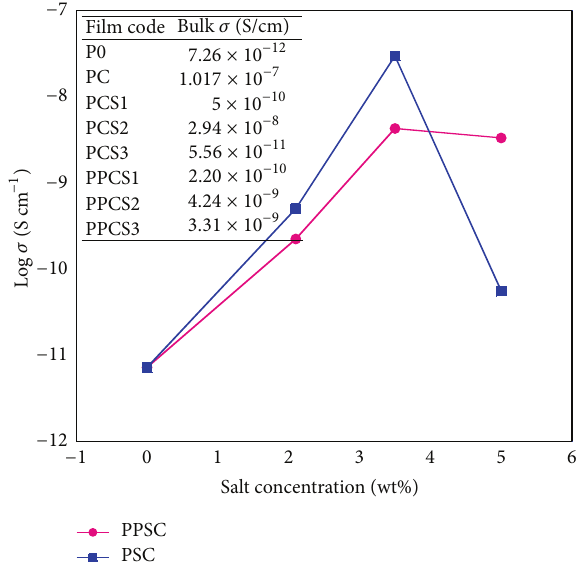
Figure 10: Bulk ionic conductivity variation for PSC and PPSC with weight % of salt for composite system at room temperature (15 ∘ C).